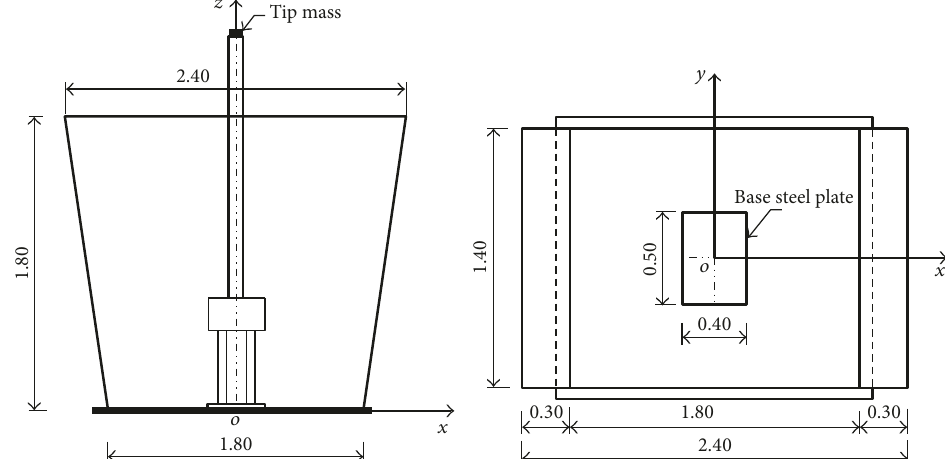
Figure 2: Dimensions of the steel water tank; all dimensions are in meters.